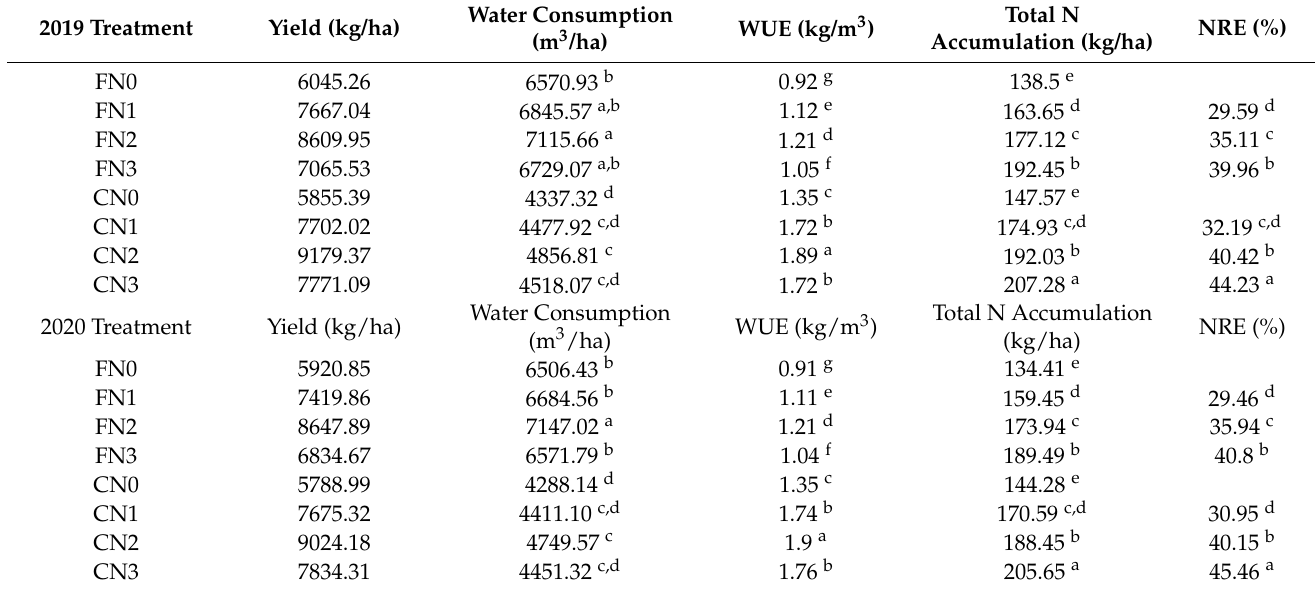
Table 3. Effects of different water and N management modes on water and nitrogen use